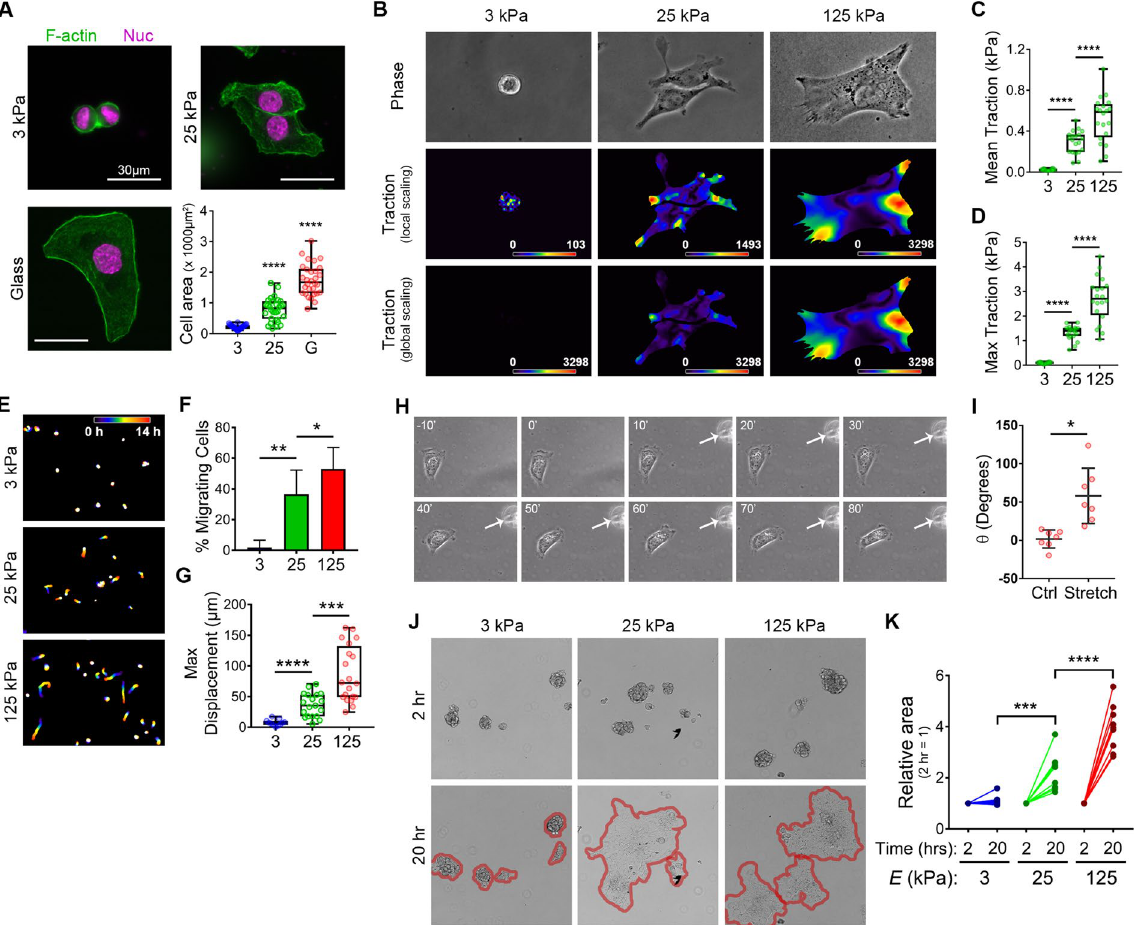
Figure 11. Substrate rigidity positively regulates cell morphology, migration, traction, and spheroid disaggregation in highly metastatic SKOV3.ip1 cells. SKOV3.ip1 cells were cultured to analyze the following experimental parameters: ( A ) Cell morphology, as described in Fig. 2 (graph depicts all data points (colored symbols), with box & whisker plots as described earlier; n = 30 cells from 3 experiments for all samples; **** p < 0.0001); ( B – D ) Traction force, as described in Fig. 4 (n = 20 cells from 3 experiments per condition); **** p < 0.001); ( E – G ) Cell migration, as described in Fig. 5 (panel (E) shows temporal color-coded tracks of the positions of cell nuclei over time; panel (F) shows mean percent migrating cells ( ± s.d.; n = 80 cells from 3 experiments; * p = 0.0287; ** p = 0.0048); panel (G) shows maximum displacements as box & whisker plots as described earlier (n = 11, 19, and 22 cells from 2 experiments for 3, 25, and 125 kPa samples, respectively; *** p = 0.001; **** p < 0.001)); ( H , I ) Durotaxis, as described in Fig. 6 (white numbers indicate time in minutes before or after the hydrogel was stretched in the direction indicated by the arrow; n = 7 cells each condition; * p = 0.002); ( J , K ) Spheroid disaggregation, as described in Fig. 7 (because of the heterogeneous size of SKOV3. ip1 spheroids, the graph in ( K ) depicts the relative area of each spheroid measured at 2 h and 20 h; n = 10 spheroids for each condition; *** p = 0.007; **** p <